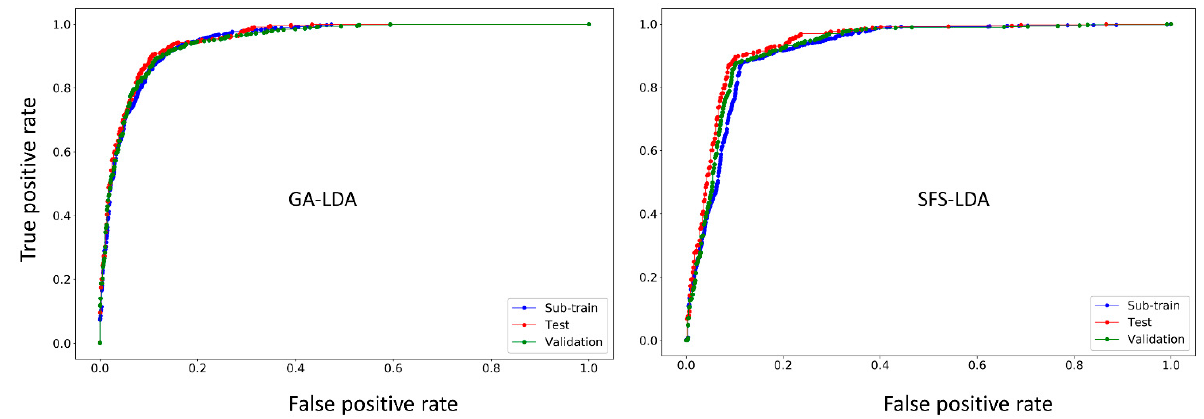
Figure 2. ROC curves for the two best linear models (GA ‐ LDA and SFS ‐ LDA).